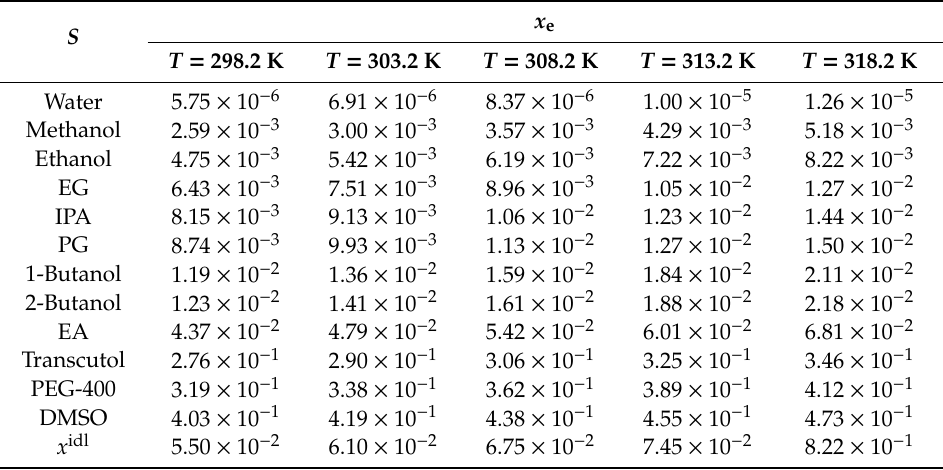
Table 1. The experimental solubilities ( x e ) of PPD in various neat solvents ( S ) at “ T = 298.2 K to 318.2 K and “ p = 0.1 MPa”